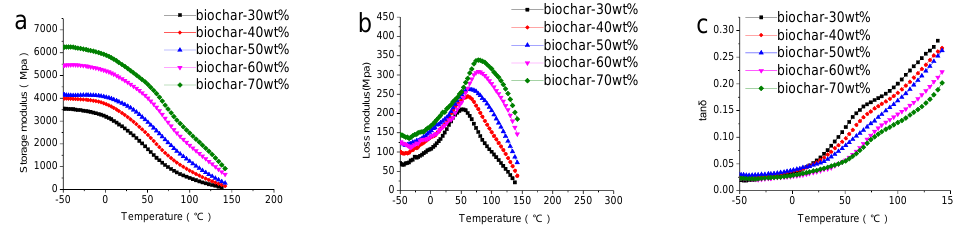
Figure 1. Variation of ( a ) E ′; ( b ) E ′′ and ( c ) tan δ with temperature for corresponding composites.